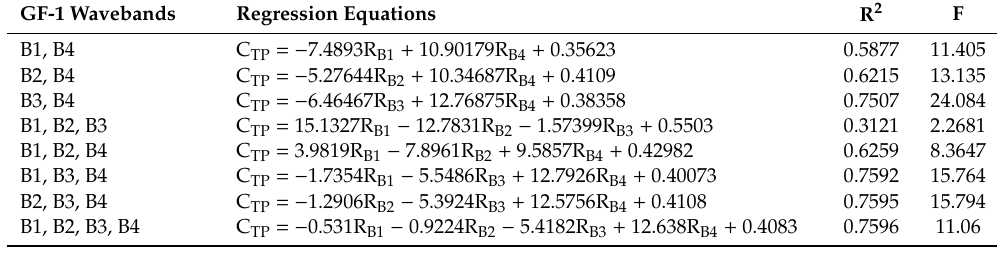
Table 5. Regression analysis of TP and the measured water leaving reflectance （ R 2 > 0.3 ）.